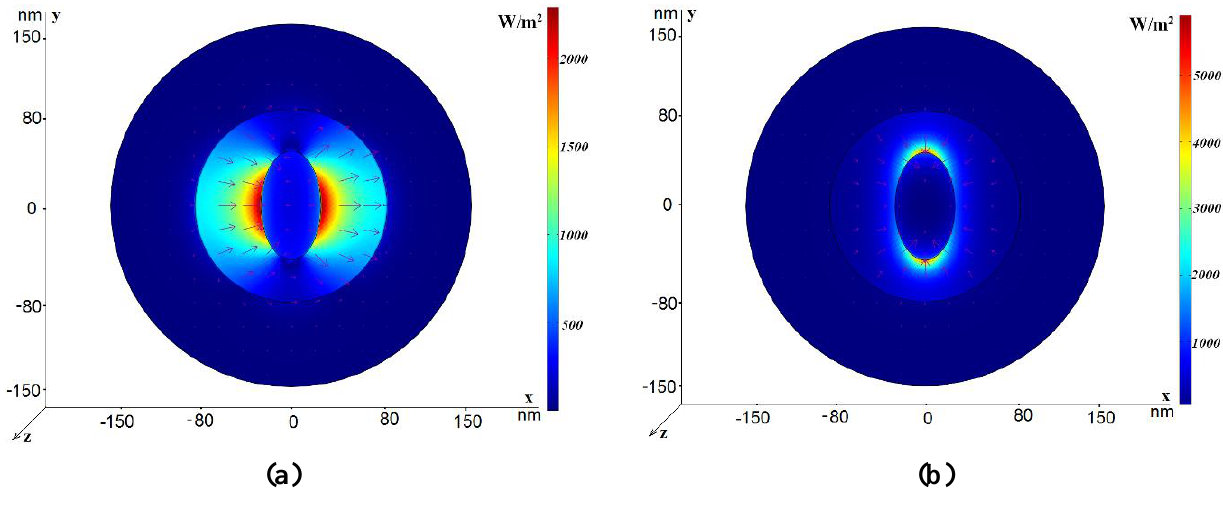
Figure 6. Power flow distribution for the dipole-like mode in the case R h = 70 nm; the large ellipse semi-axis is 45 nm and the small ellipse semi-axis is 25 nm. 2 The electric field vector is shown by arrows. ( a ) The dipole-like mode n ( b ) The TEM-like mode n = 3.06 + i 0.046. eff